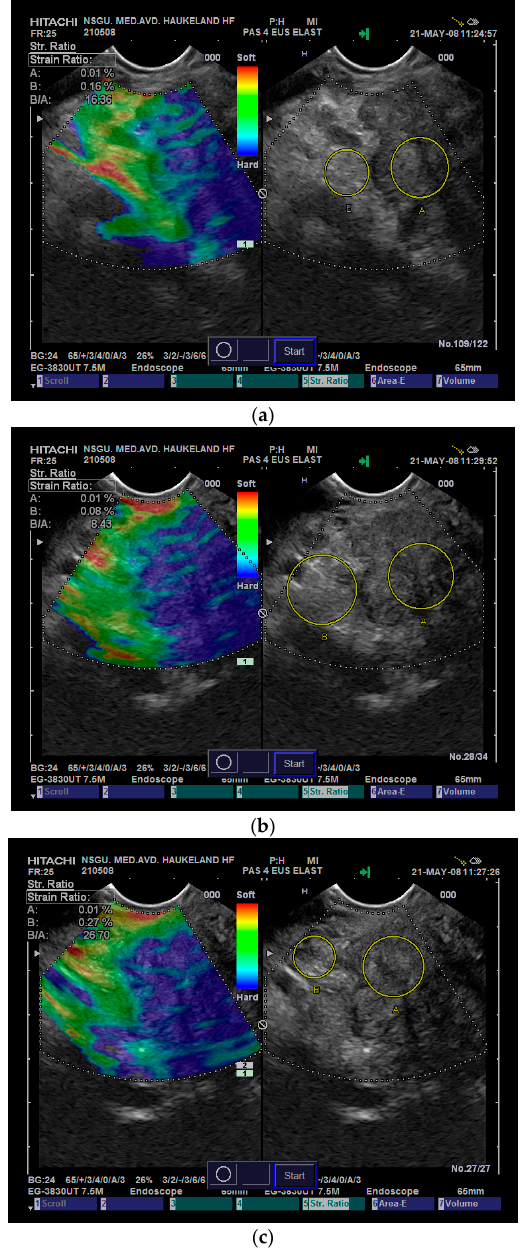
Figure 5. Three images of the same pancreatic tumor visualized by endoscopic ultrasound (EUS) elastography. Tumor tissue is blue in the elastograms with a predominantly green reference tissue. The position and size of the reference tissue vary slightly between the three different images, and exhibit different strains in all three images: ( a ) 0.16%; ( b ) 0.08%; and ( c ) 0.27%, whereas the strain in the lesion remained at 0.01%. This causes the SR values to vary from 8.43 to 26.7.